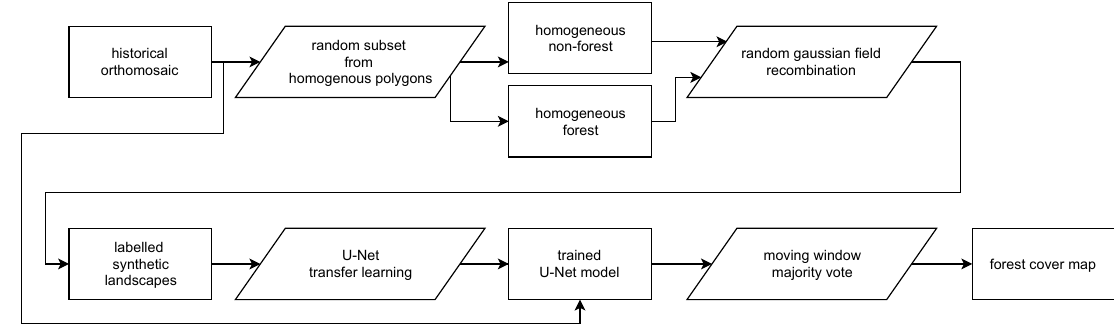
Figure 6. A diagram of the deep learning workflow followed in training a binary forest/non-forest cover convolutional neural net U-Net model to generate our forest cover